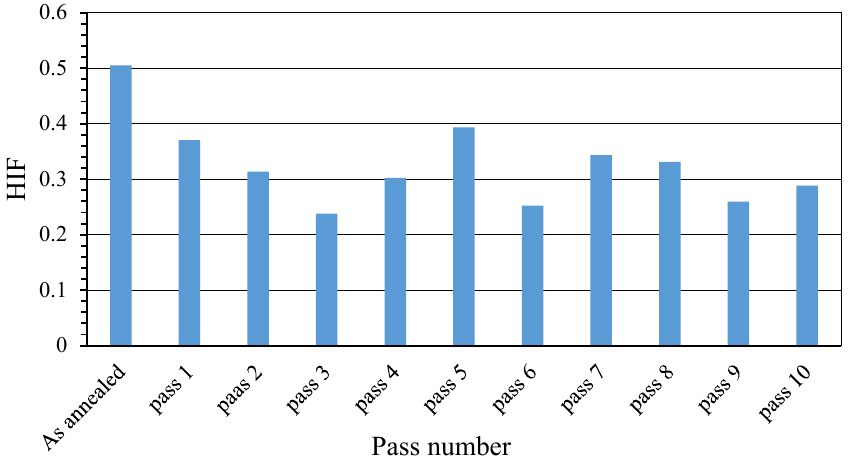
Figure 15. HIF for the as annealed sample and the first pass to tenth